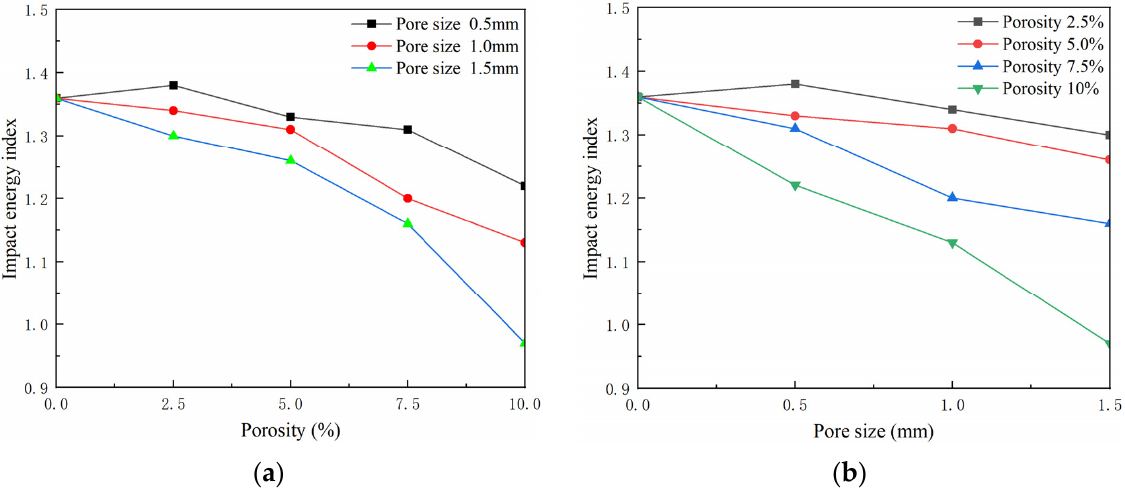
Figure 10. Variation curve of impact energy index of specimens under different pore characteristics. ( a ) Impact energy index-porosity relationship diagram; ( b ) Impact energy index-pore size relationship diagram.